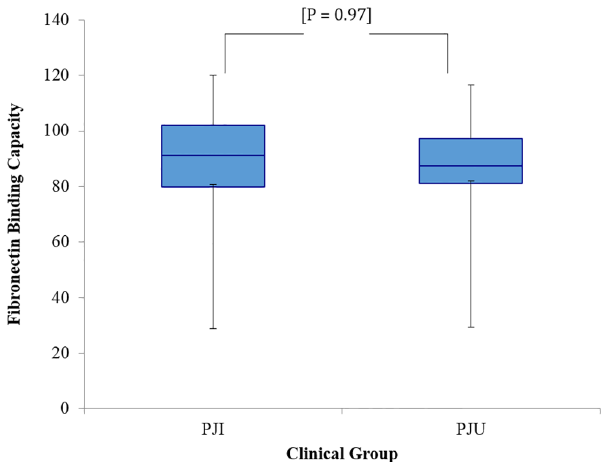
Fig 4. Comparison of the fibronectin binding capacity of S . aureus isolates from prosthetic joint infection (PJI) and uninfected prosthetic joint (PJU) groups. Values were calculated as percentage capacity to bind fibronectin relative to S . aureus control strain 8325 – 4. Box ends represent the 25 th and 75 th percentiles, and whisker ends represent the minimum and maximum. There was no difference in fibronectin binding capacity between isolates in the PJI and PJU